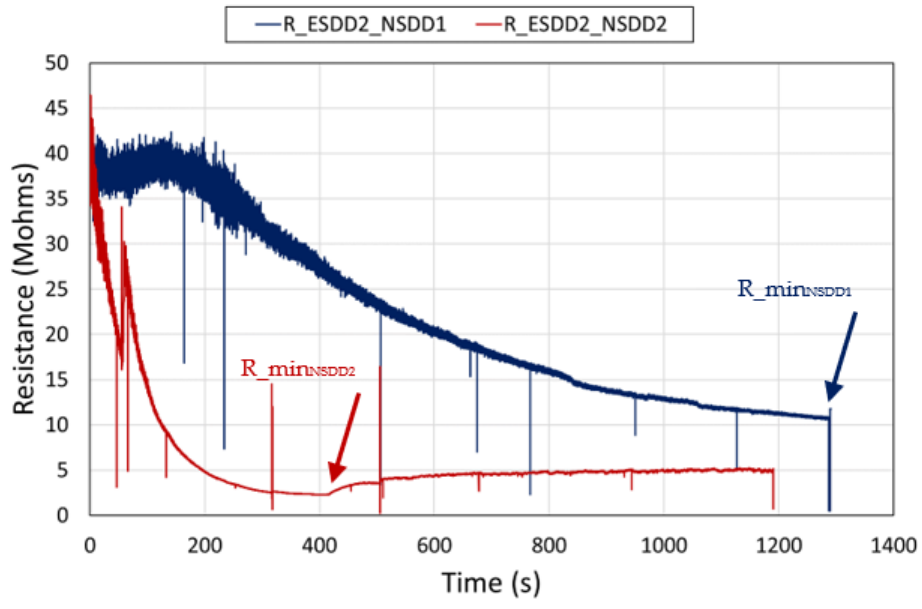
Figure 11. Leakage resistance during the low-voltage (840 V) test with ESDD 2 .